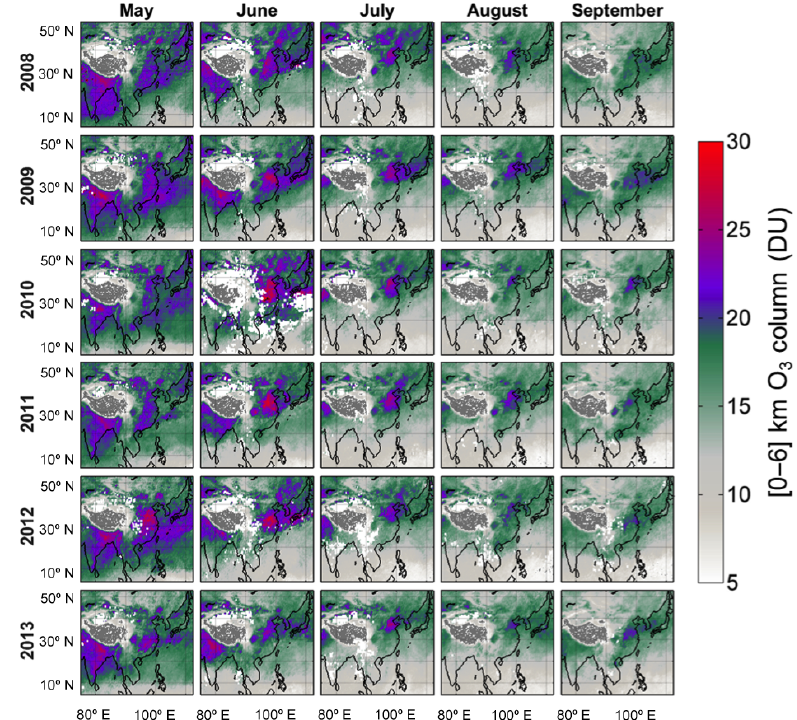
Figure 1. Monthly averaged daytime tropospheric 0–6km O 3 column from IASI over the EASM region and period (May–September) for the years 2008–2013. The decrease due to the monsoon is more prominent to the south of the